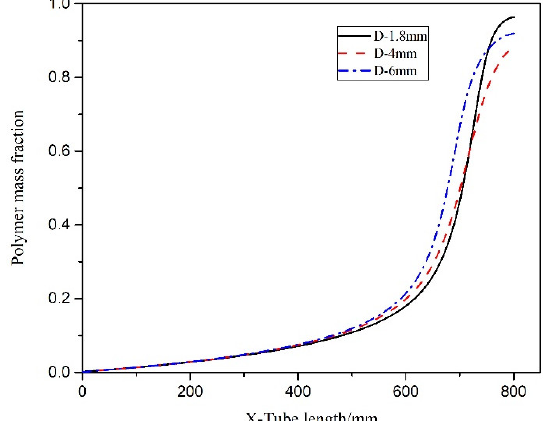
Figure 8. Temperature distribution curve of the central axis under adiabatic conditions.